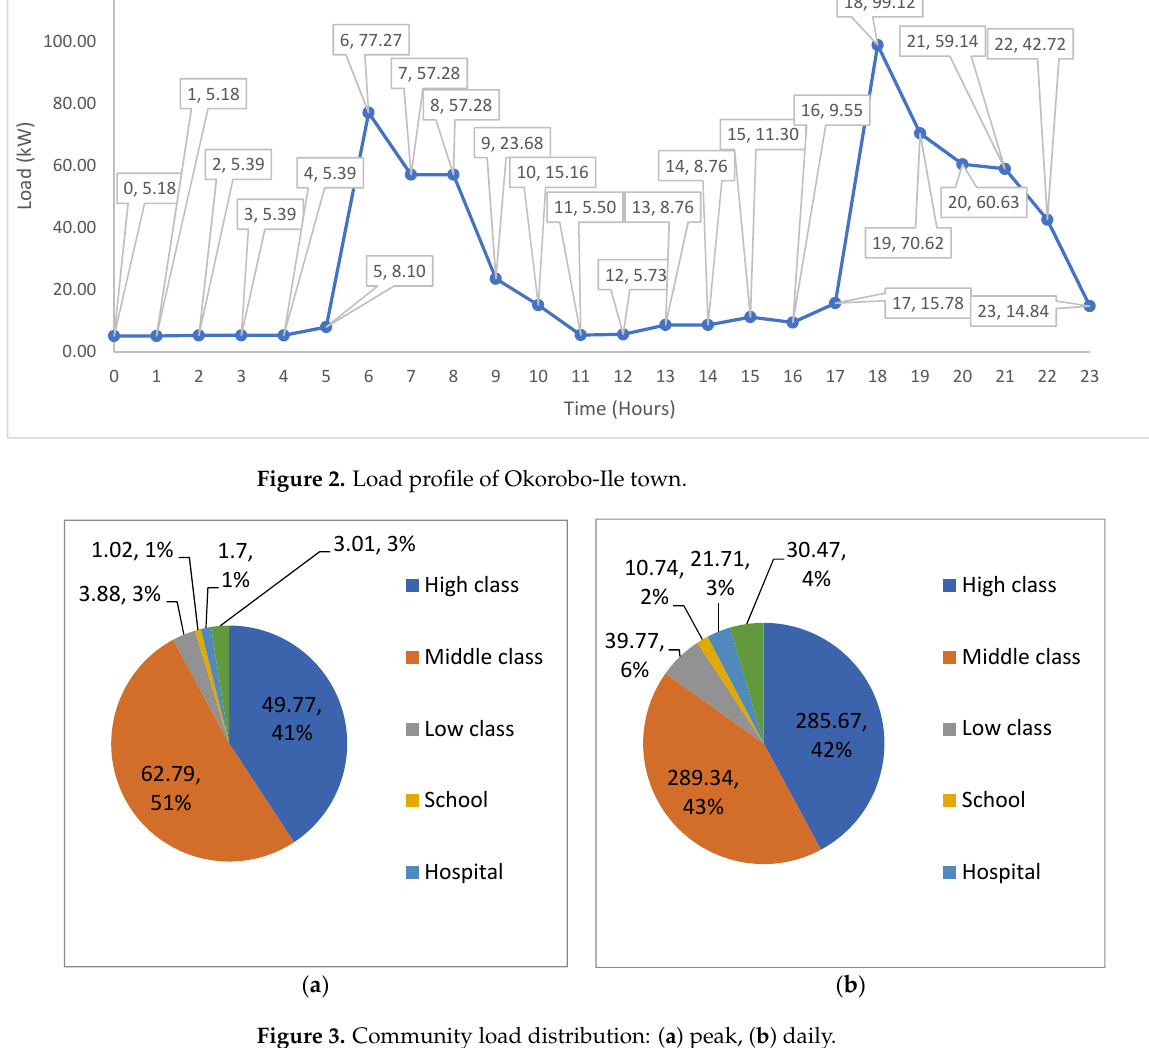
Figure 3. Community load distribution: ( a ) peak, ( b ) daily.